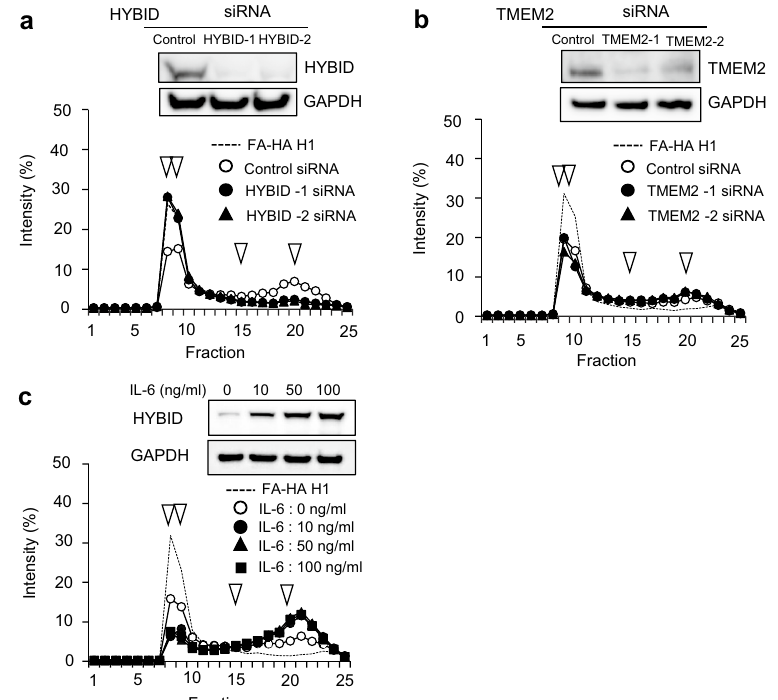
Figure 3. HYBID-dependent HA-degrading activity in OA chondrocytes and increased HA-degrading activity in IL-6-treated OA chondrocytes. ( a ) Abrogation of HA-degrading activity by siRNA-mediated